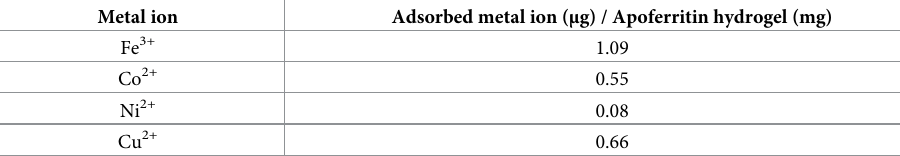
Table 1. Amounts of metal ions adsorbed to the apoferritin